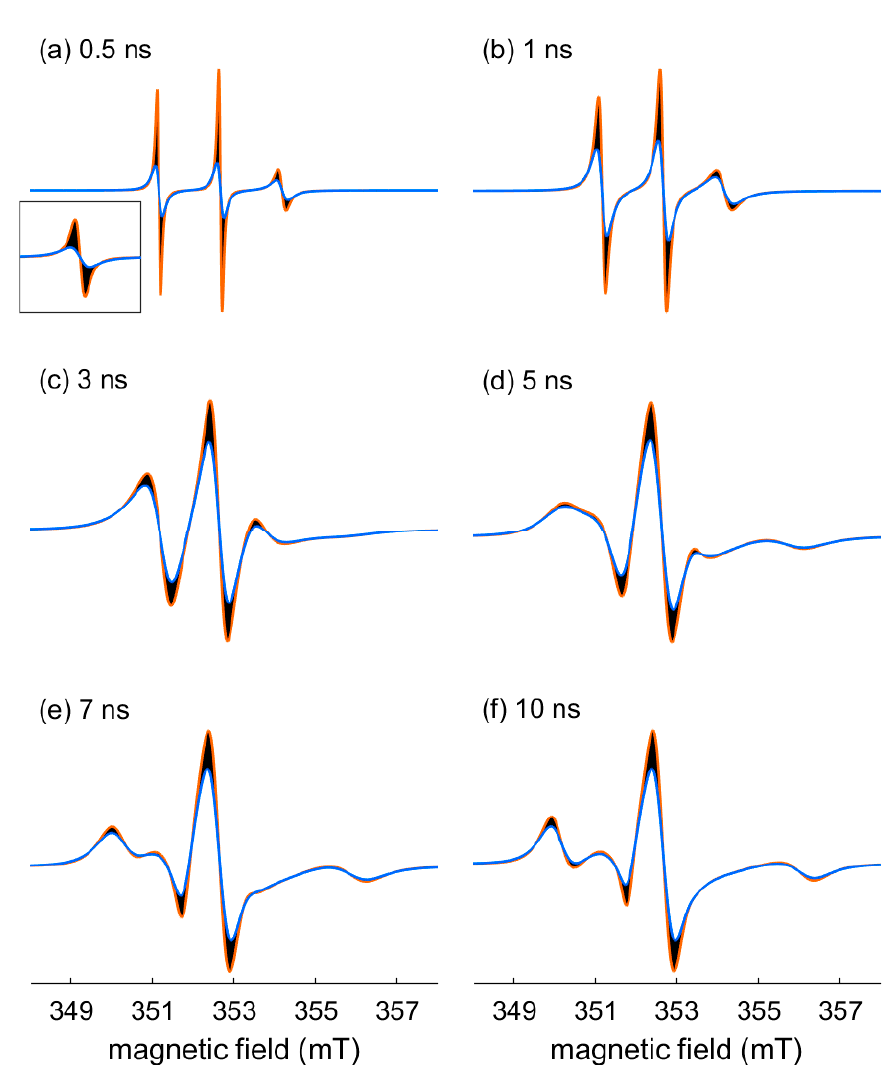
Figure 4. Influence of the variations of the additional Lorentzian broadening (0 ≤ lw lor ≤ 0.15 mT) on the nitroxide X-band cw EPR spectral shape for: ( a ) t corr = 0.5 ns; ( b ) t corr = 1 ns; ( c ) t corr = 3 ns; ( d ) t corr = 5 ns; ( e ) t corr = 7 ns; ( f ) t corr = 10 ns. Each panel is the superposition of 100 simulated spectra (black traces) with lw lor varying from 0 to 0.15 mT. The spectra obtained with no broadening (lw lor = 0) and lw lor = 0.15 mT are colored (orange and blue trace, respectively). Inset in panel ( a ): zoom of the low field line. All the spectra are normalized to their integrated intensity. Parameters for the simulations: g x = 2.0084, g y = 2.0061, g z = 2.0022, A xy = 0.45 mT = 12.6 MHz, A z = 3.66 mT = 102.6 MHz, at 9.9 GHz.